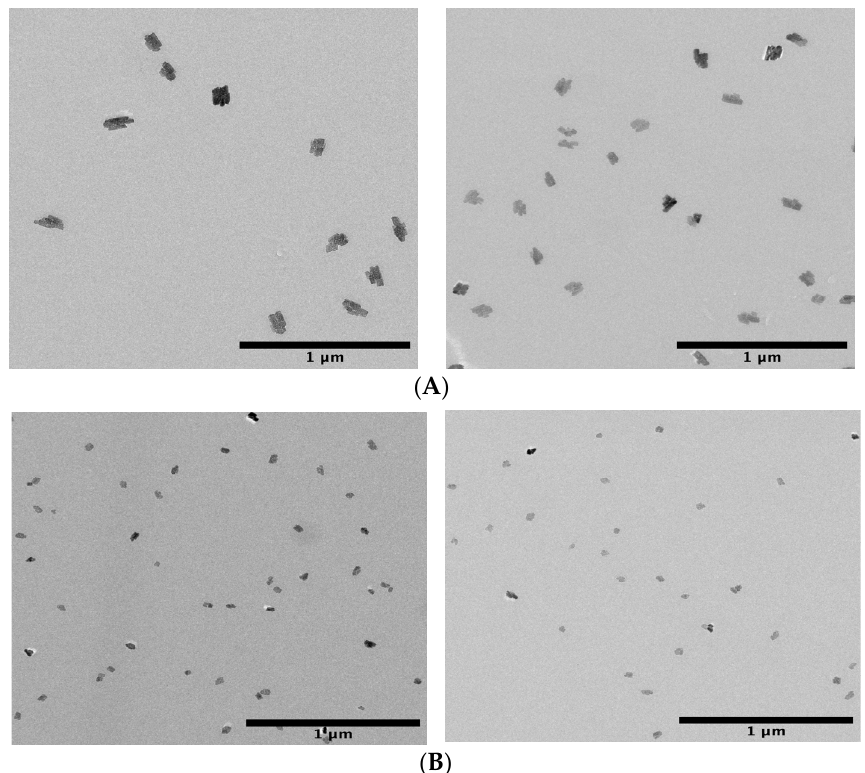
Figure 10. TEM images of PLA/n-BGs nanocomposites: ( A ) PLA/n-BGs 5 wt.% and ( B ) PLA/n-BGs 10 wt.%.